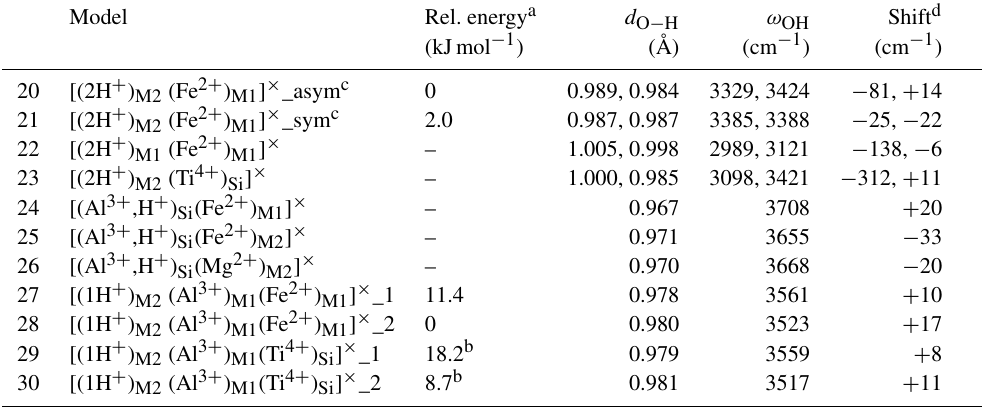
Table 2. Theoretical properties of selected defects with nearby isovalent substitutions (structure files are provided in the Supplement). Model